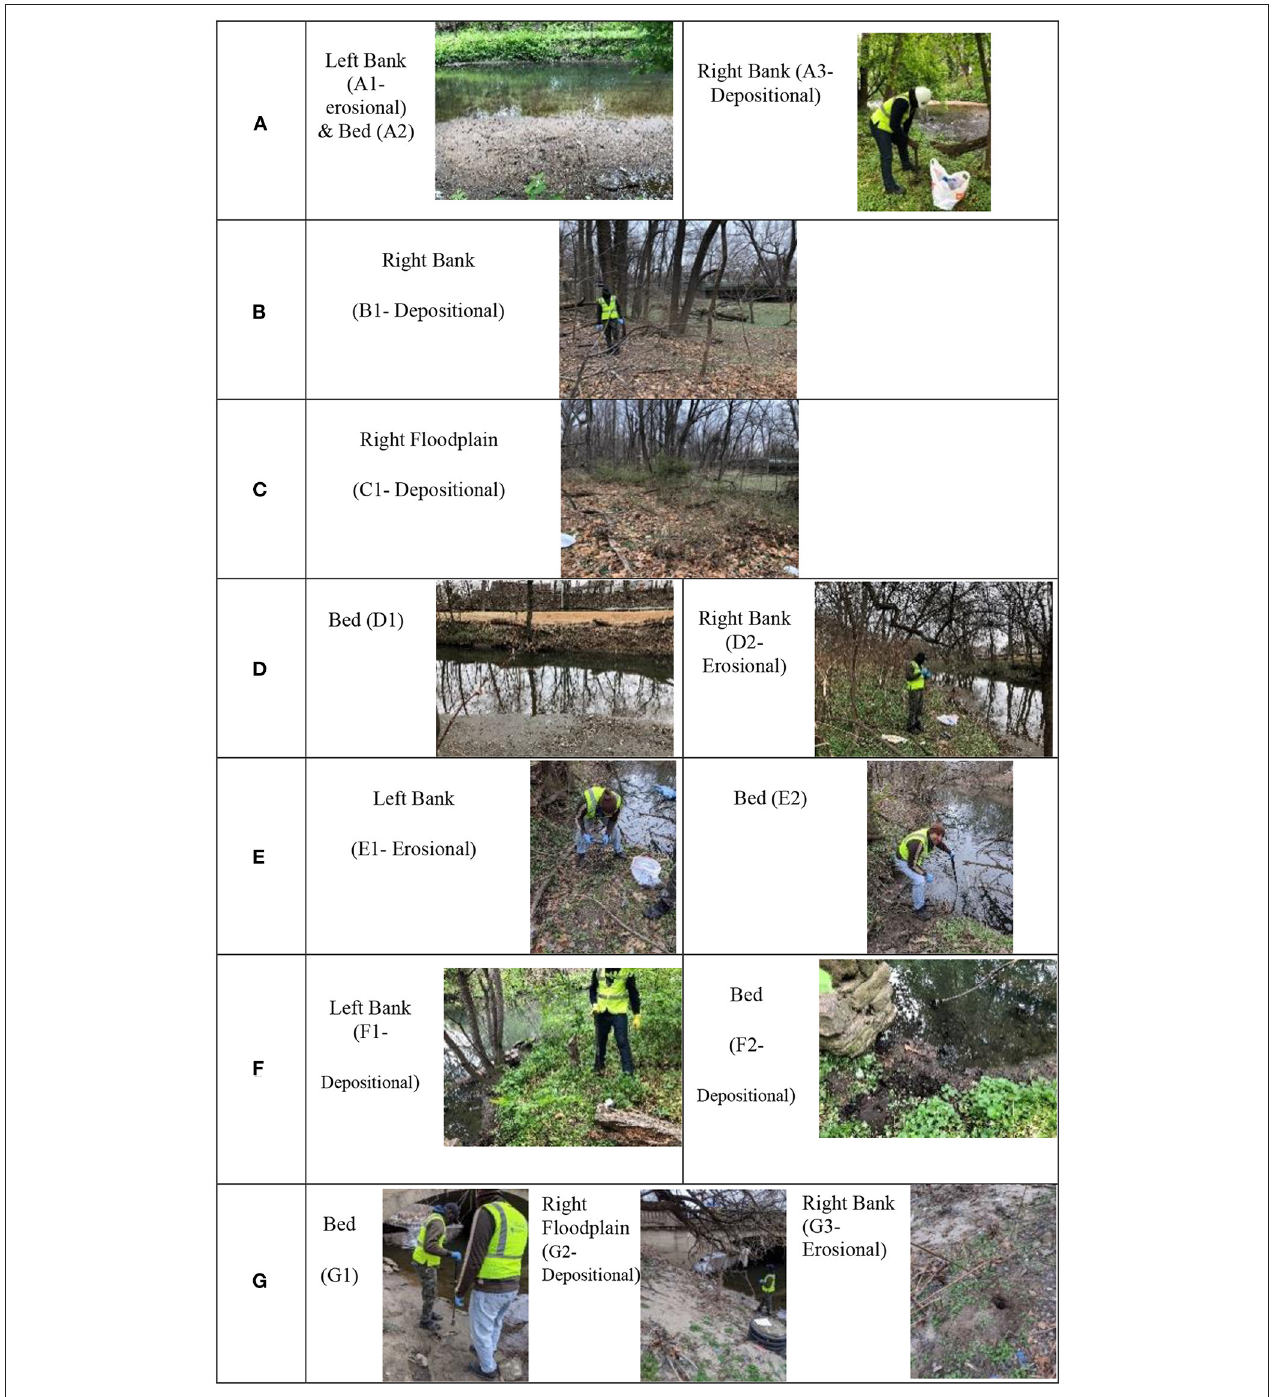
FIGURE 3 | (A–G) Samples were collected from different sites along the creek and erosional or depositional sites were identified.